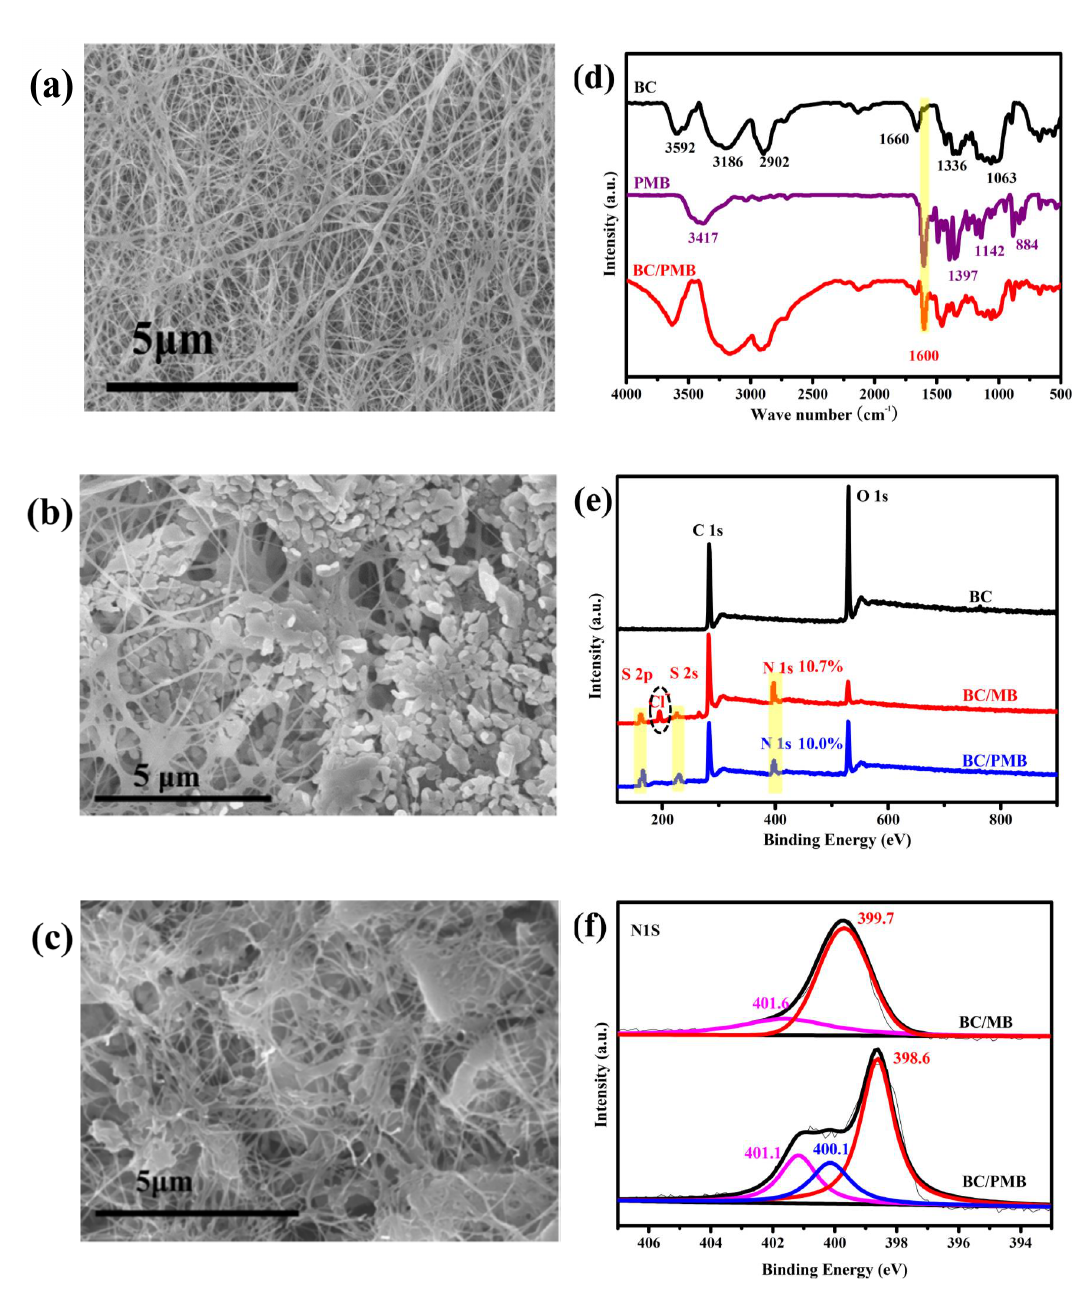
Figure 2. SEM images of ( a ) BC; ( b ) BC/MB and ( c ) BC/PMB; ( d ) FTIR spectra of BC, PMB and BC/PMB; ( e ) XPS survey spectra of BC, BC/MB and BC/PMB; and ( f ) fine XPS spectra of N1S for the BC/MB and BC/PMB.